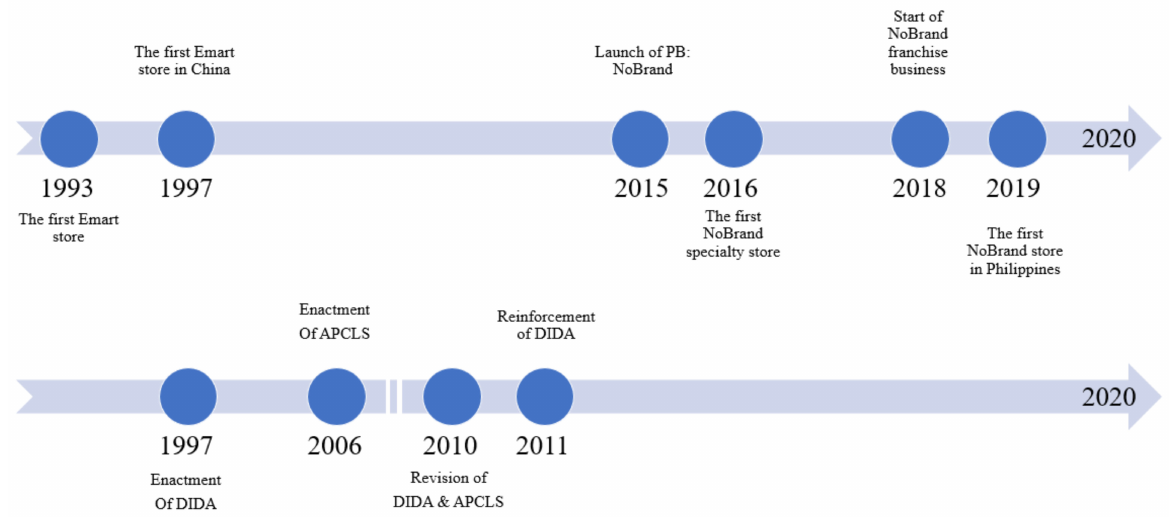
Figure A1. Timeline of Emart and NoBrand development and retail regulation. Sources: National Law Information Center, Emart and NoBrand website